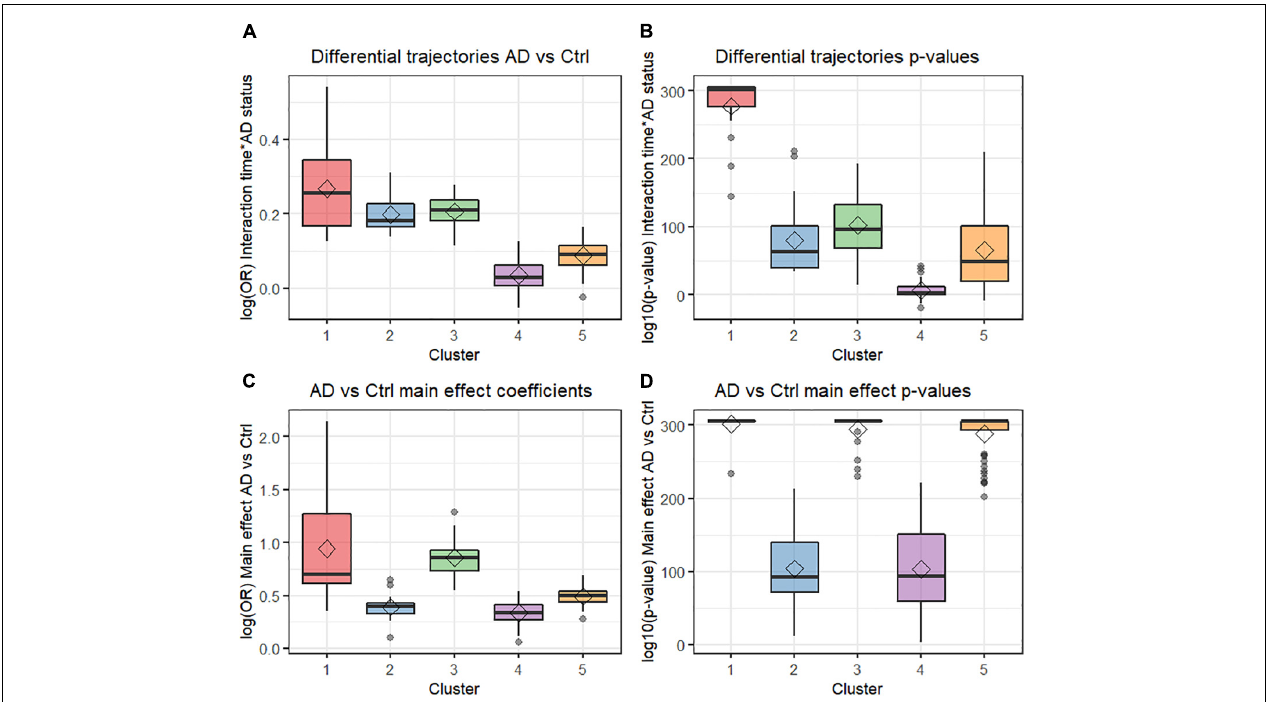
FIGURE 2 | Box plots from multivariate analysis. (A) Differential trajectories AD vs. control. (B) Differential trajectories p -values. (C) AD vs. control effect coefficients. (D) AD vs. control main effect p -values. AD, Alzheimer’s disease; Ctr, Control; OR, Odds